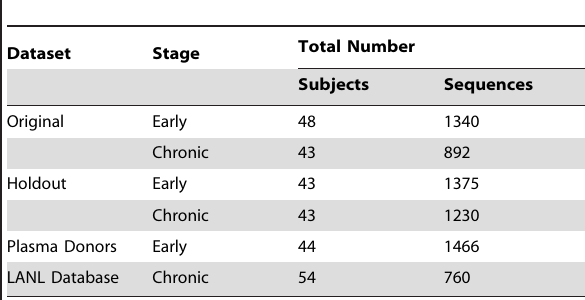
Table 1. Number of subjects and SGA sequences used in this